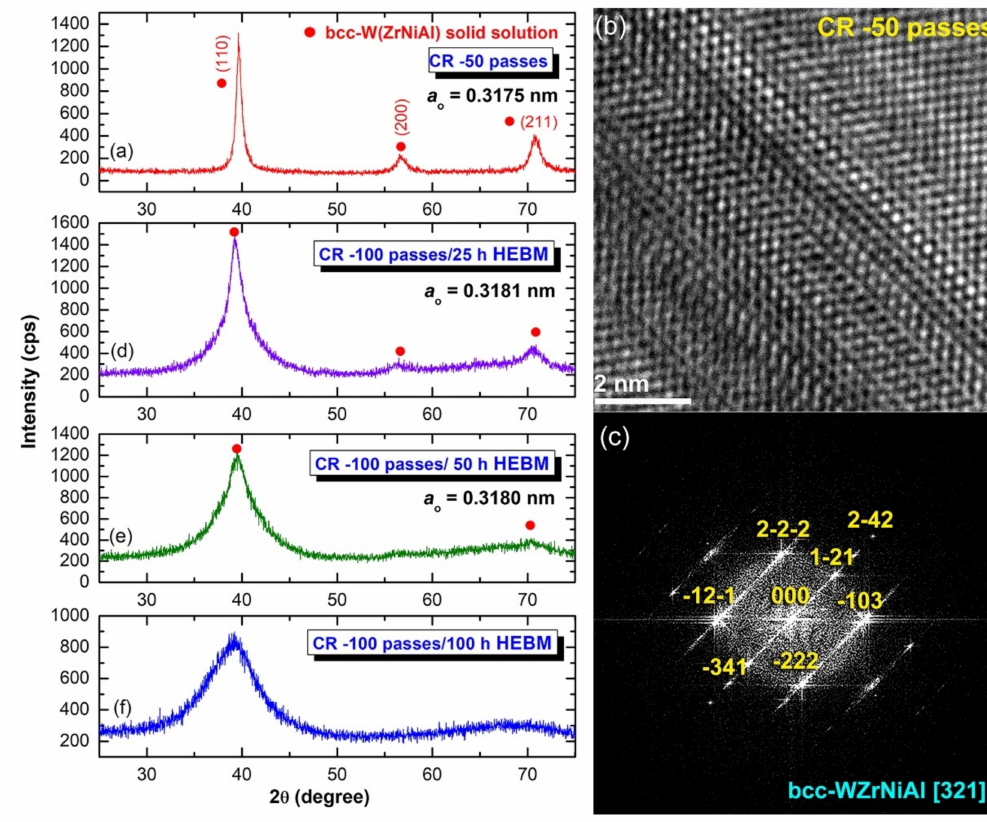
Figure 5. ( a ) XRD patterns of as-CR-(Zr 75 Ni 25 Al 5 ) 65 W 35 powders for 50 passes, ( b ) atomic resolution lattice image of 50 CR passes, and ( c ) Fast Fourier transform (FTT). The XRD patterns of as-CR-(Zr 75 Ni 25 Al 5 ) 65 W 35 powders for 100 passes and then HEBM for 25 h, 50 h, and 100 h are displayed in ( d – f ), respectively.